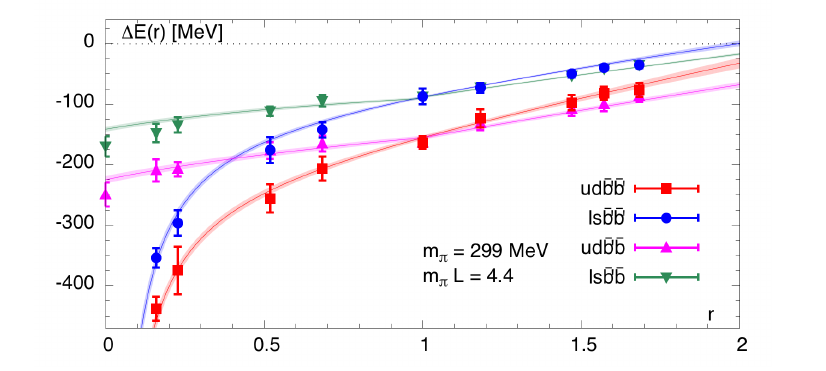
Figure 2. The dependence on the heavy-quark mass ratio, r = m b the ud ¯ b (cid:48) ¯ b , ud ¯ b (cid:48) ¯ b (cid:48) , (cid:96) sb (cid:48) b and (cid:96) sb (cid:48) b (cid:48) channels. The solid lines show the fits obtained using Eqs. (1)-(3).